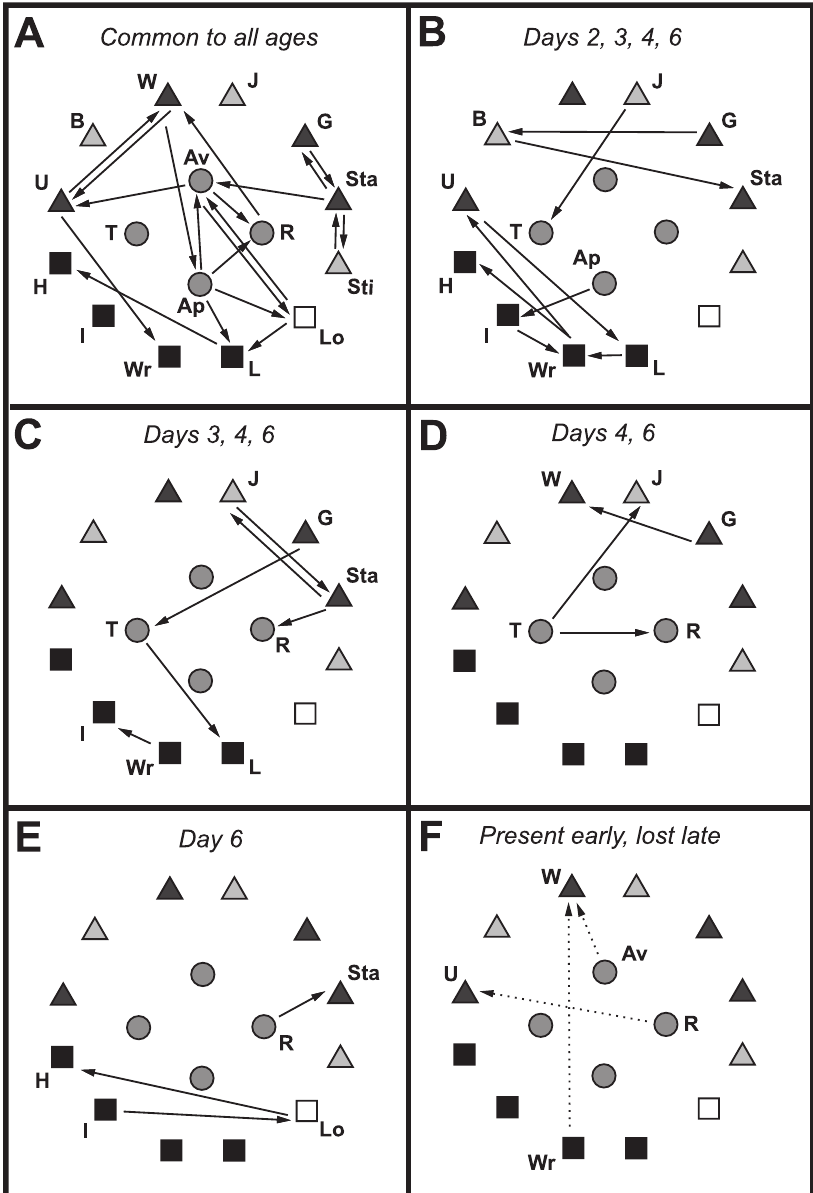
Figure 12. Summary of progressive changes in behavioral transitions with age. Simplified kinematic diagrams illustrating trends associated with the progressive ontogeny of aggressive behavior in male flesh flies. Symbols indicate the particular behaviors and arrows the direction of the transitions that occurred more often than predicted by chance, as in Fig. 6; abbreviations as in Table 1. (A) Behavioral transitions common to all age cohorts. (B) Transitions not present on day 1 of age, but existing from day 2 onwards. (C) Transitions absent on days 1 and 2, but present from day 3 onwards. (D) Transitions not present on days 1, 2, and 3, but existing on days 4 and 6. (E) Transitions present on day 6 but not observed prior to that. (F) Three transitions that were eliminated, rather than added. Av-W and Wr-W were present on days 1, 2, and 3, but absent on days 4 and 6. R-U was present on days 1–4 but absent on day 6.